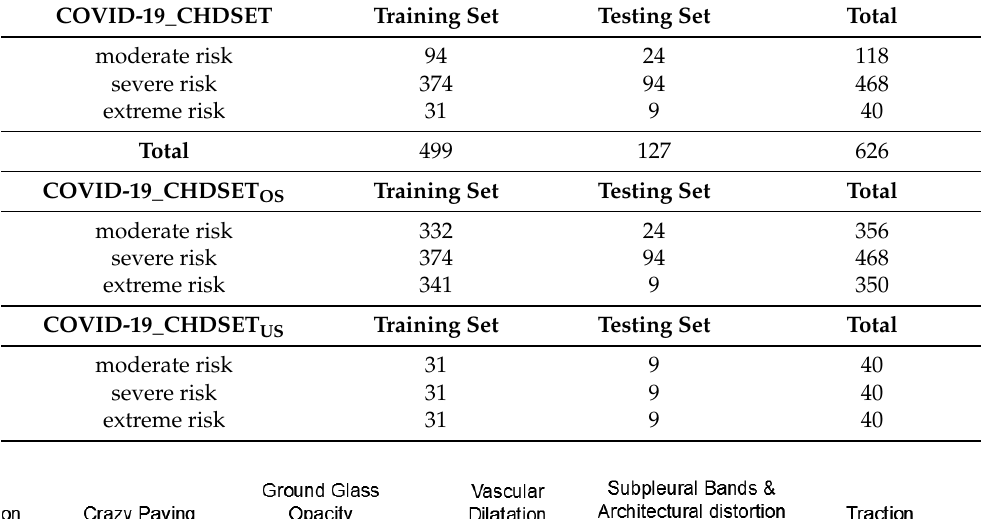
Table 1. Distribution of the available Computed Tomography (CT) scans into the three classes, the training, and the test set.